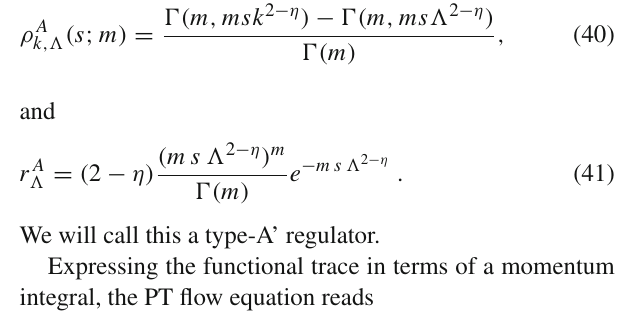
actual calculations the Runge–Kutta integrator DO2PVF 2 turned out to be rather efficient. Continuity at the fitting point of the functions Z , V and their derivatives is obtained by means of a globally convergent Broyden’s method. 3 In